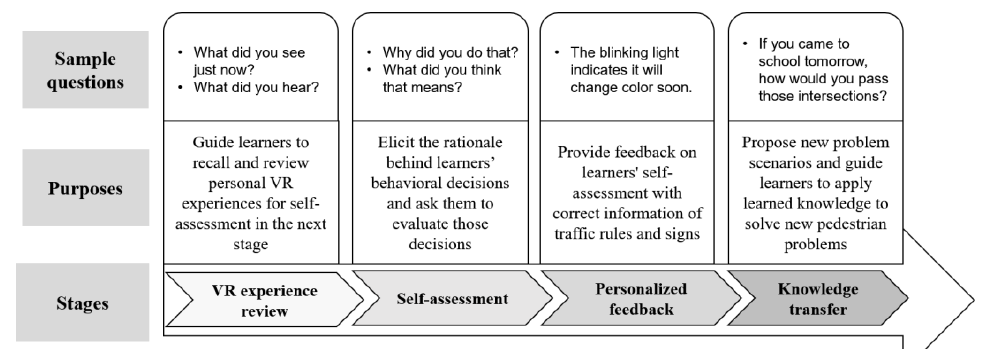
Figure 2. The instructional design of the debriefing strategy based on IVR